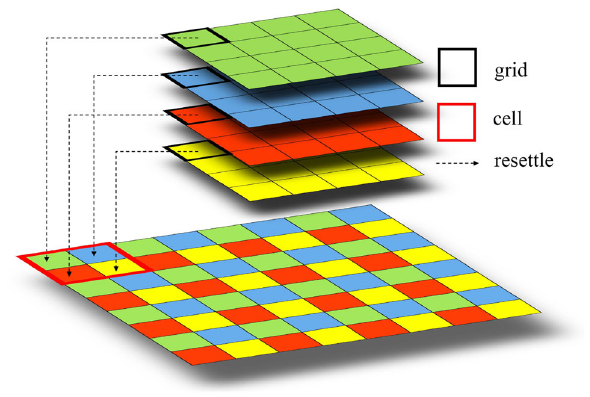
Fig. 3 Pixel shuffle module. The input feature map will be divided as four parts in channel wise like the yellow, red, green and blue sub- features,andeachpartisresettledadjacentlytoformanenlargedfeature